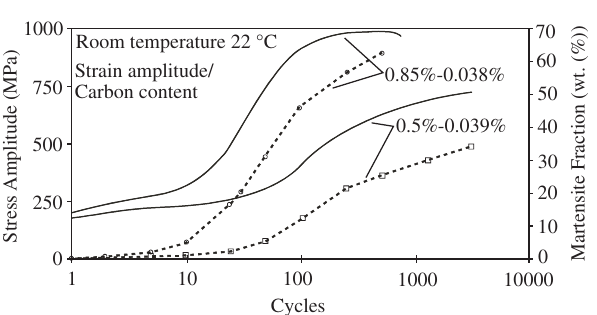
Figure 8. Influence of total strain amplitude on decarburised test speci-